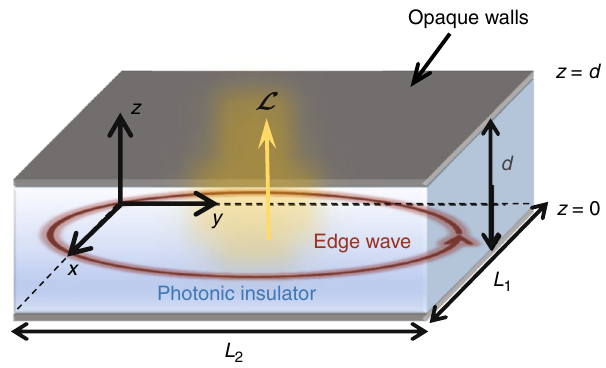
Fig. 1 Geometry of a generic “ photonic insulator ” cavity. The closed electromagnetic cavity does not support bulk states in some spectral range ( “ photonic insulator ” ). The lateral walls (not shown) may eventually enable the propagation of edge-type waves con fi ned to the boundary. The thermal fl uctuation-induced light is generally characterized by a non-trivial angular momentum L , which for a suf fi ciently large cavity has a quantized spectral density in a